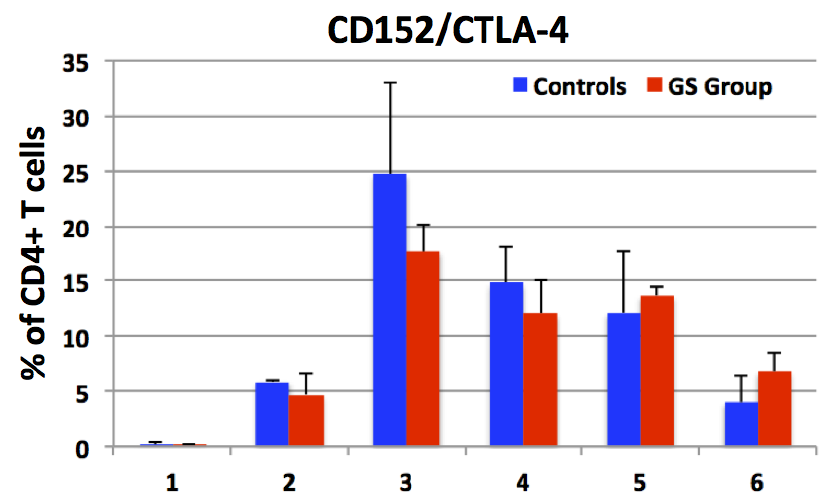
Figure 4. The proportions of CD152 (marker of T cell inhibition) expression by peripheral CD3+CD4+ T cells from control (C = blue columns) and gluten-sensitive (GS = red columns) macaques were evaluated. Six selected time points are shown including the GFD day 28 (X axis value 1); conventional barley diet days 14 (2) and 43 (3); RG barley diet days 28 (4) and 42 (5); followed again by GFD day 13 (6). While only the minimal expression